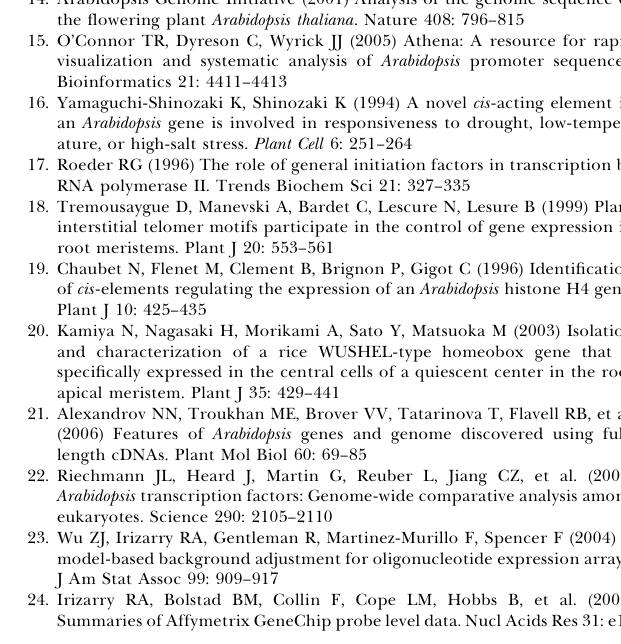
Figure S7. Mean Gene Length, Intron Length (All Intronic Segments per Genes Added Up), and Number of Introns of Genes as a Function Table S1. Set of 43 AtGenExpress Treatment-Control Gene Expres- sion Profiling Experiments Used in the Analysis Found at doi:10.1371/journal.pgen.0030011.st001 (25 KB